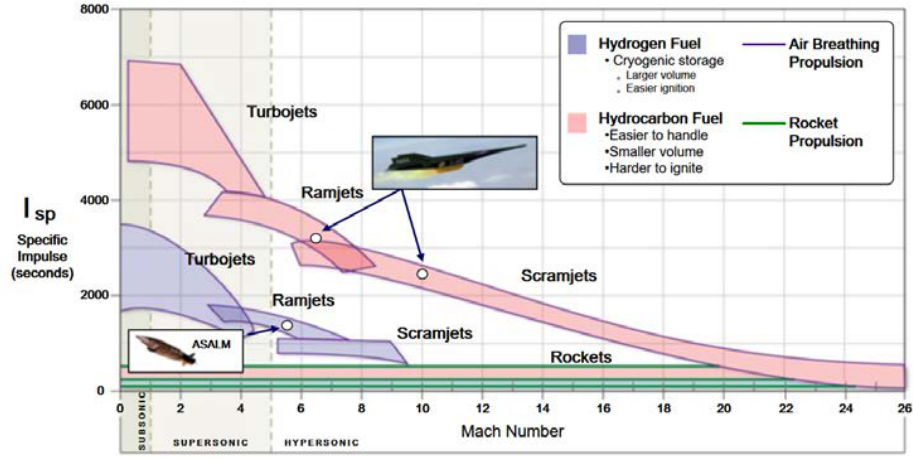
Figure 1. Operation envelopes of air breathing engines.